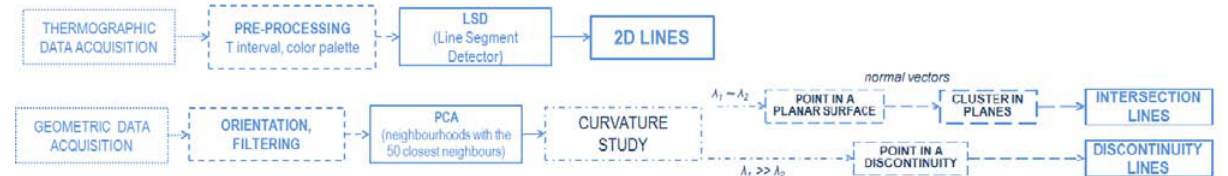
Figure 1. Workflow Part 1: extraction of 2D lines from thermographic images and 3D lines from the point